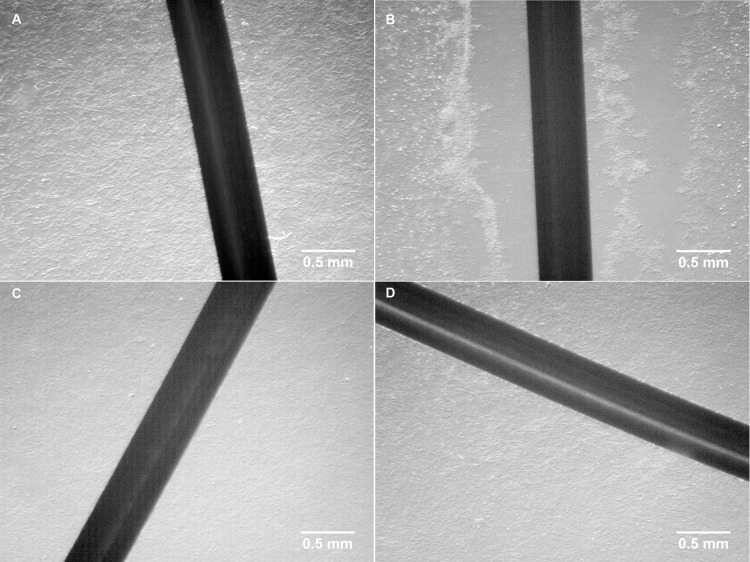
Visual appearance of cultured porcine fibroblast cells before and after treatment.(A) cells before electrical biostimulation; (B) cells in Chamber I (the anode) after exposed to electrical biostimulation (380 nA) for 21 hours; (C) cells in Chamber II (the cathode) after exposed to electrical biostimulation (380 nA) for 21 hours; (D) cells in Chamber III (no current as vehicle control) after exposed to electrical biostimulation (380 nA) for 21 hours.